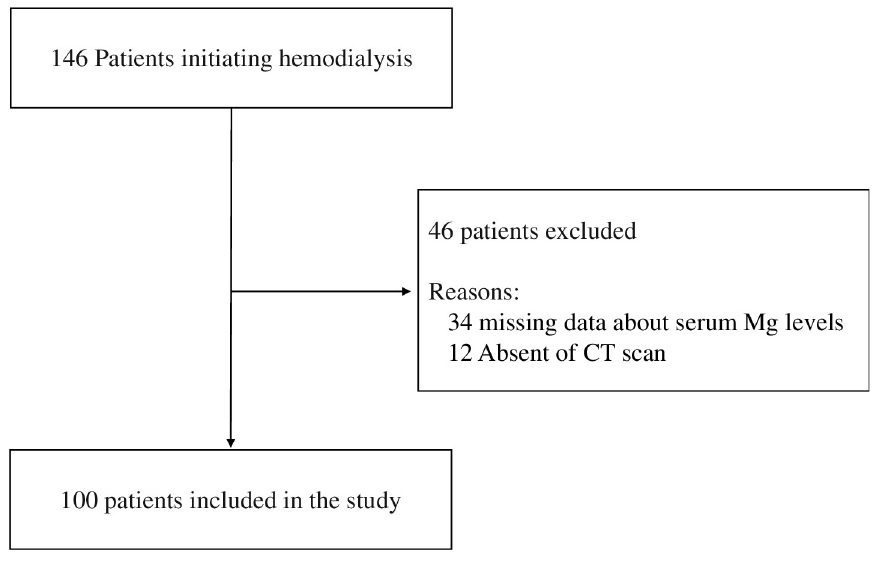
Fig 1. Flow diagram of patient